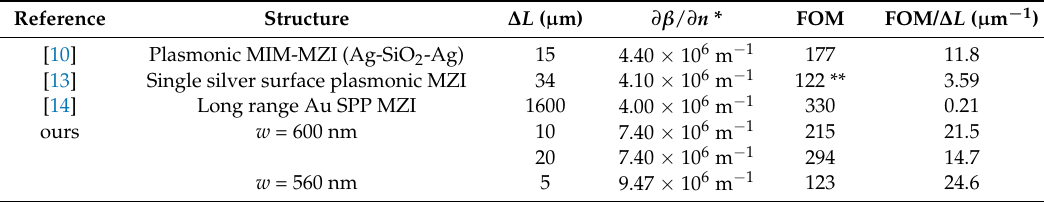
Table 3. The path length differences, change of the propagation constant, FOM and FOM per unit path length differences for the typical plasmonic MZIs and the proposed MZI